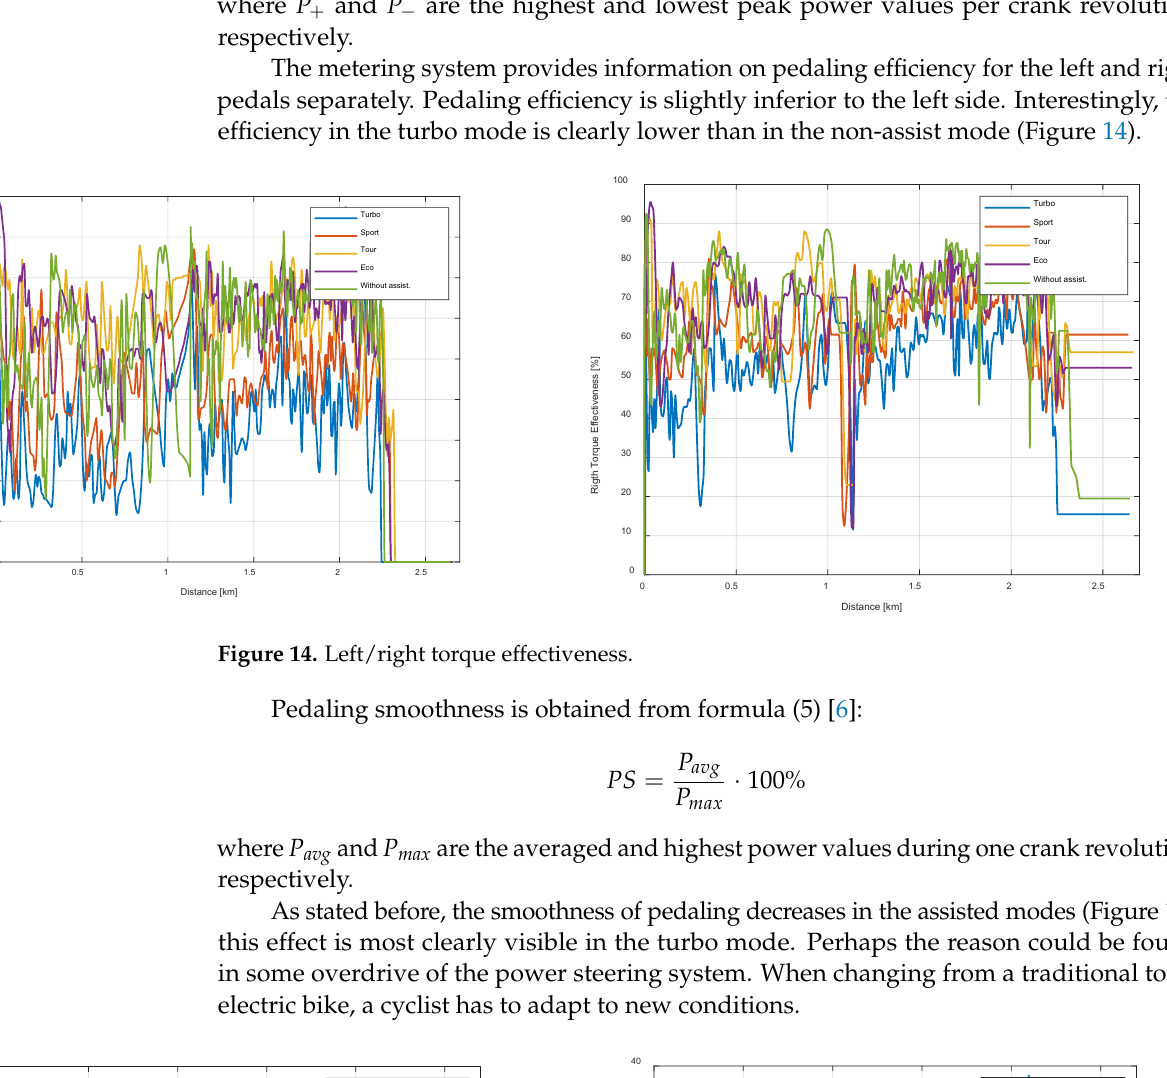
Figure 13. Left/right power balance as a function of power for all modes simultaneously.